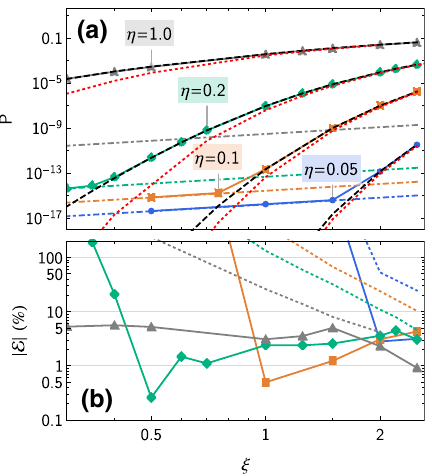
Fig. 3 a Paircreationprobability P foraphotonwithenergyparameter η colliding with a circularly polarised plane-wave laser pulse of peak amplitude ξ with N = 16cycles.Resultsfromtheoryareplottedfor η = 0 . 05 (blue), η = 0 . 1 (orange), η = 0 . 2 (green) and η = 1 . 0 (grey), (all- orders: solid, perturbative: dot-dashed), as well as results from LMA- based simulations (black, dashed) and LCFA-based simulations (red, short-dashed). b Percentageerrormadebythesimulations(LMA:solid, LCFA: dashed), calculated using Eq.